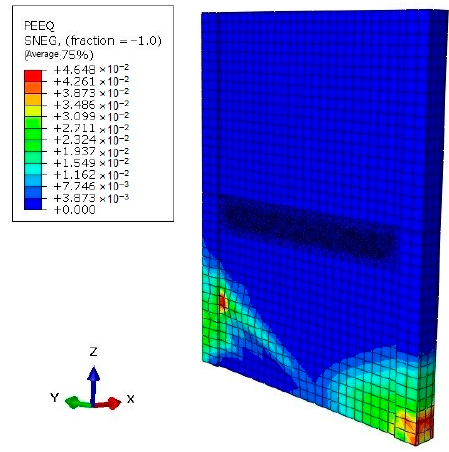
Figure 10. PEEQ of concrete for SPRC-2 (1).